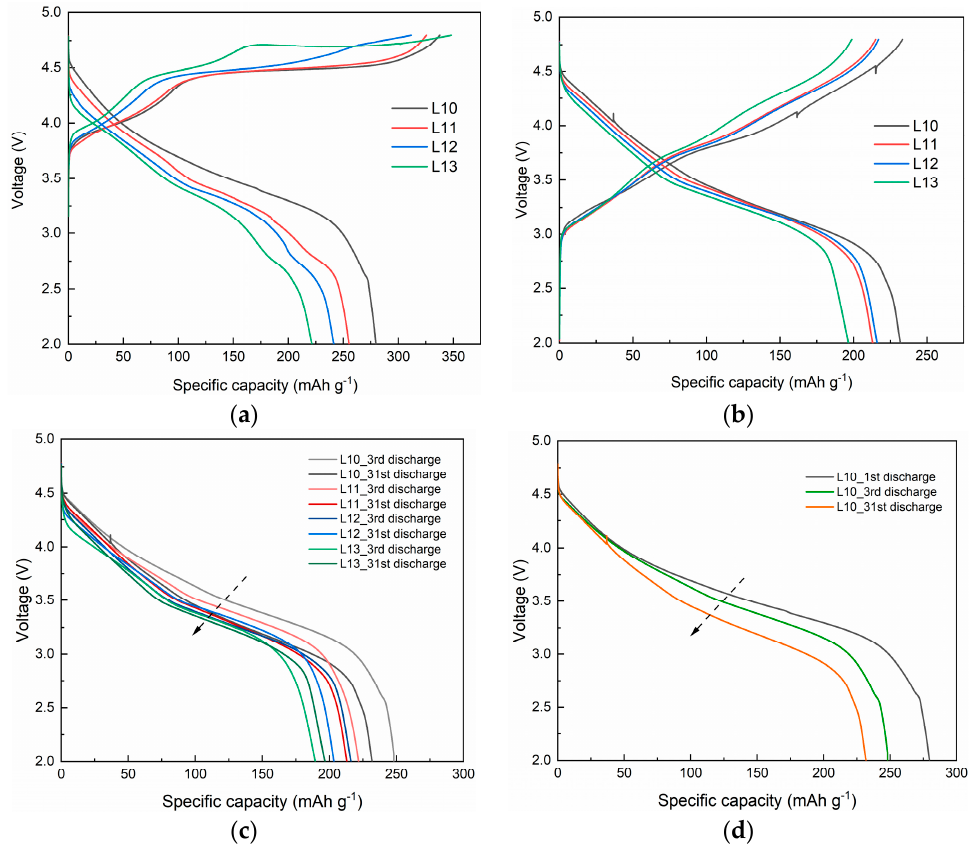
Figure 3. ( a ) Initial charge–discharge profiles of L10–L13 at 0.03 C within 2.0–4.8 V; ( b ) charge- discharge profiles of L10–L13 for the 31st cycle at 0.1C within 2.0–4.8 V; ( c ) Voltage profiles of L10–L13 for comparison of 3rd discharge and 31st discharge; ( d ) Voltage profiles of L10 for comparison of the 1st discharge, 3rd discharge and 31st